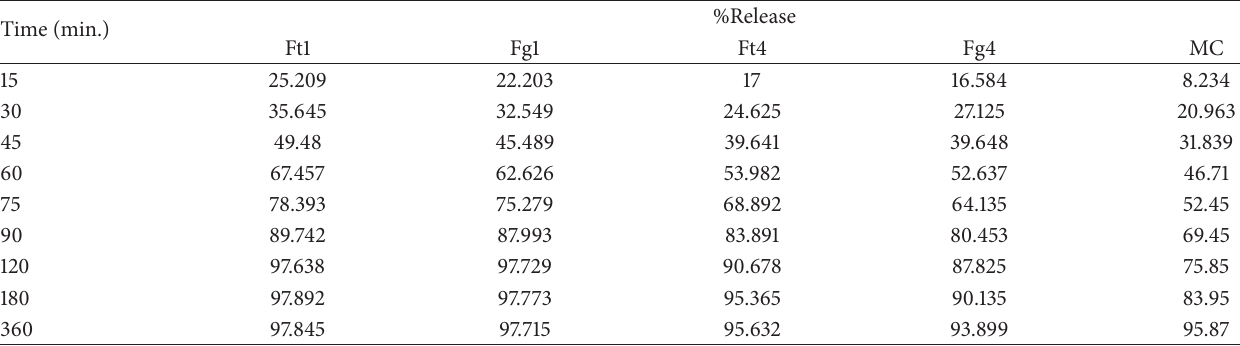
Table 6: Ex vivo release data of different formulations.